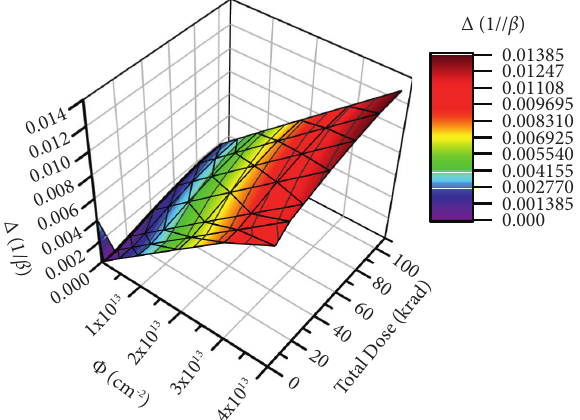
Figure 5: 3D figure of synergistic effects.